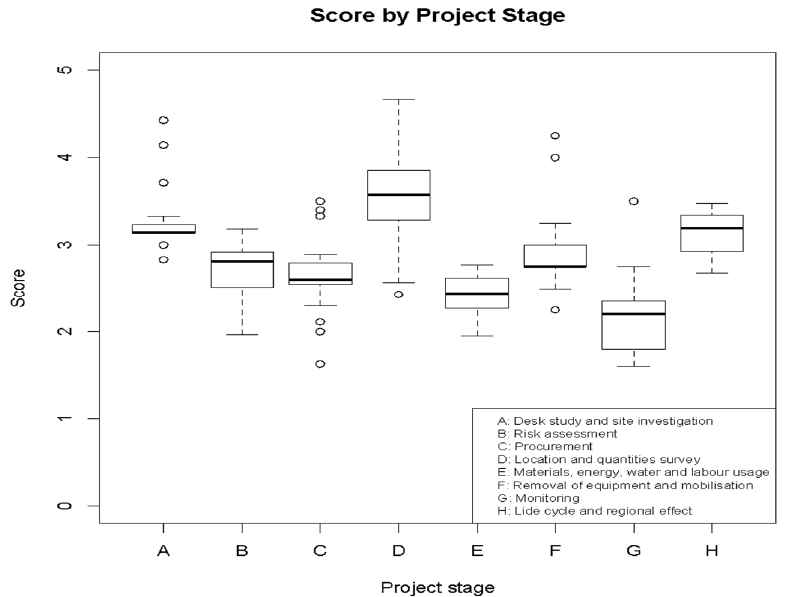
Figure 8. Overall average sustainability performance score per project stage. Baseline sustainability score is 3.0. The lower edge of the box corresponds to the 25th percentile data point, while the top edge of the box corresponds to the 75th percentile data point. The line within the box represents the median. The highest and lowest scores excluding outliers are shown in the upper and lower whiskers. The outliers in stages A, C, and F denote high score variability between the data points. These differences were also consistent when they were evaluated for each project type individually (Coastal: F = 2.965, df = 7, p < 0.05; Fluvial: F = 37.57, df = 7, p < 0.01; Hill slope: F = 12.29, df = 7, p < 0.01; Figure 9.).